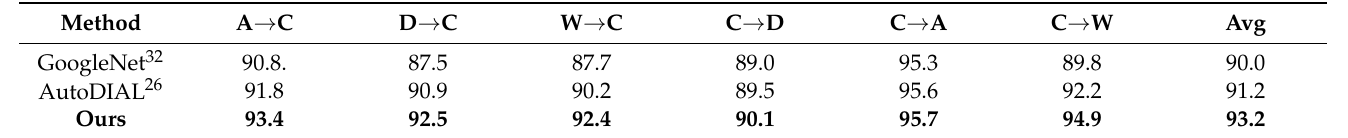
Table 3. Classification accuracy (%) of the Office-Caltech dataset for unsupervised domain adapta- tion